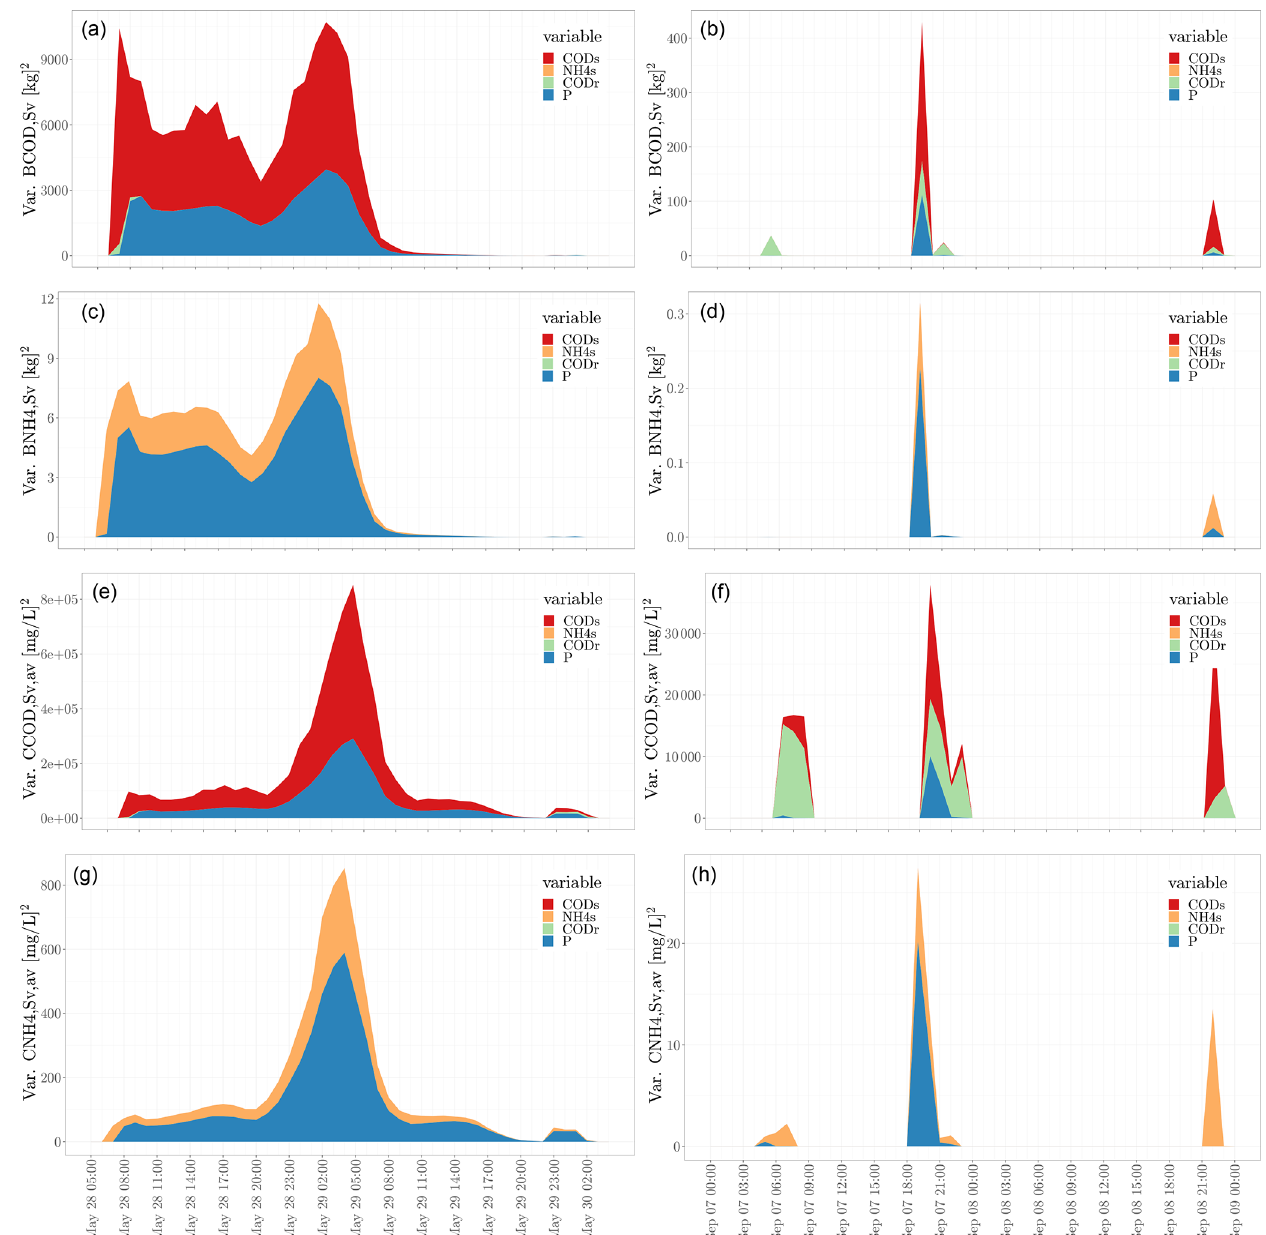
Figure 4. (a, b) Temporal contributions of input variables to the load of overflow COD, (c, d) load of overflow NH 4 , (e, f) concentration of overflow COD, and (g, h) concentration of overflow NH 4 in terms of variance. The MC simulations were performed for the entire year of 2010 at a 10min time step, which were aggregated to hourly time steps. For illustration, two periods are shown from 28 to 30 May 2010 (left) and from 7 to 9 September 2010 (right). In the legend, CODs refers to C COD , S , and NH4s refers to C NH